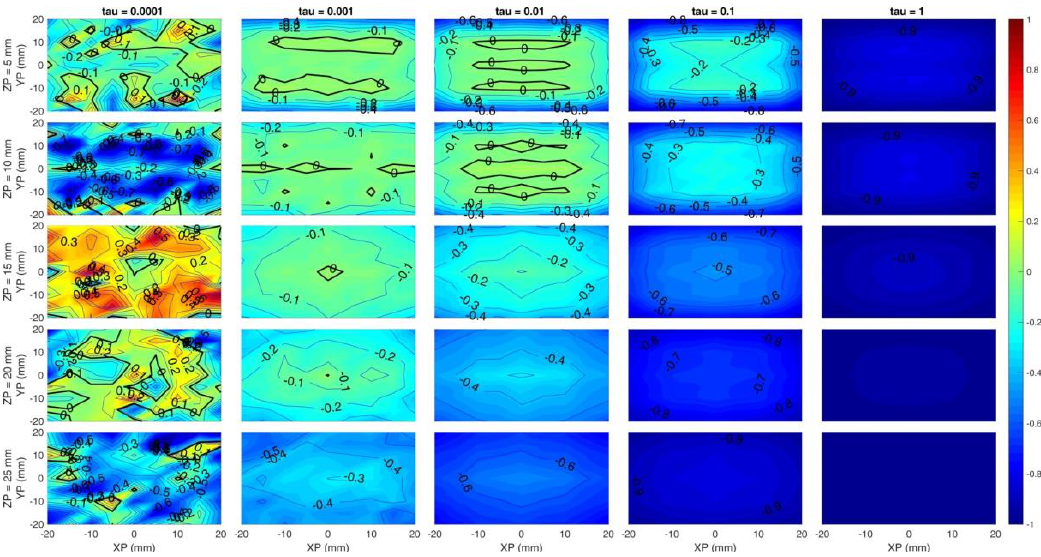
Figure 6. Map of the volumetric error on the absorption coefficient. The horizontal axis of each subplot is the simulated x position of the inclusion and the vertical axis is the simulated y position. Rows are for different z coordinates of the inclusion, while columns are for different 𝜏 . Colors show an error of − 100% (blue) to +100% (red).